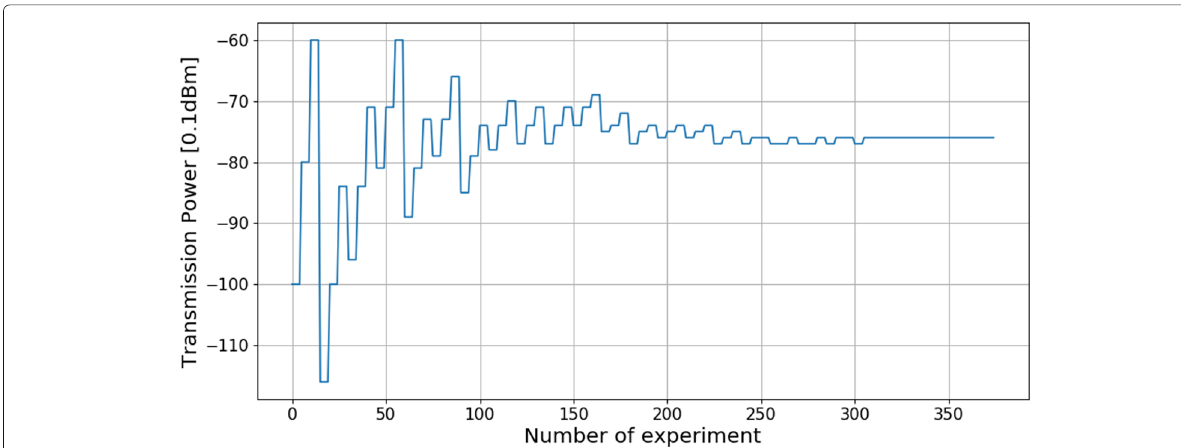
Fig. 8 Serving cell transmission power adjustment